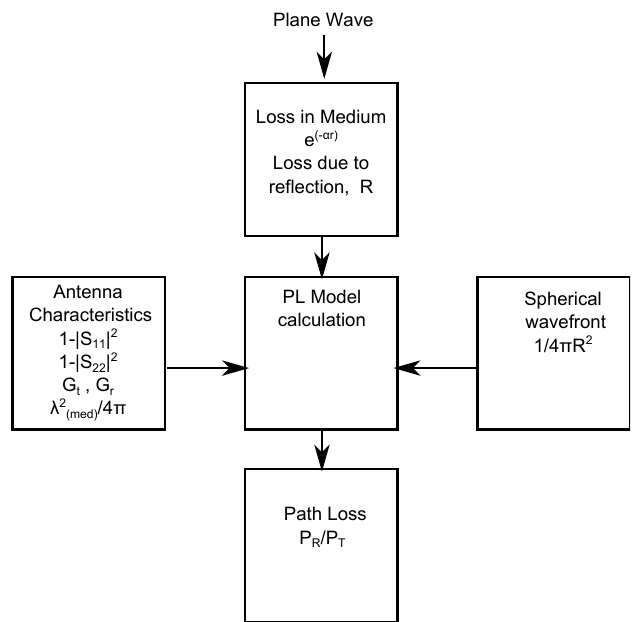
Figure 5. Block diagram of path loss (PL)